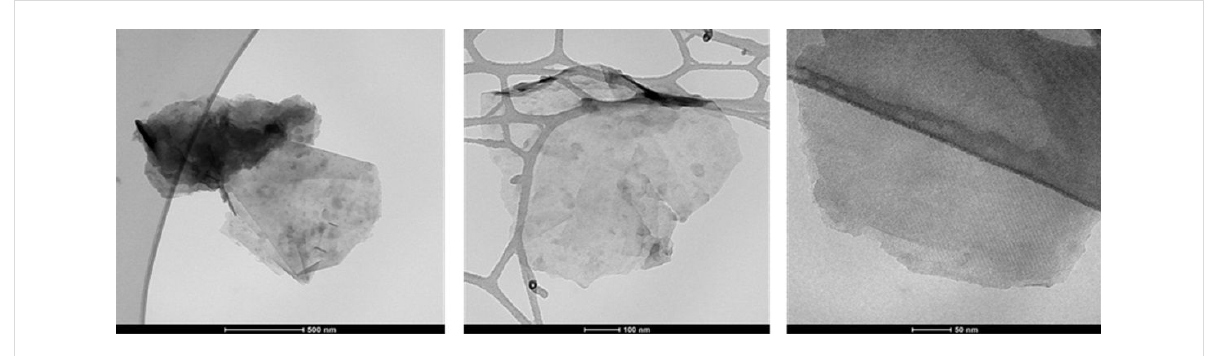
Figure 6: TEM images of graphene sample sheets GAE1.